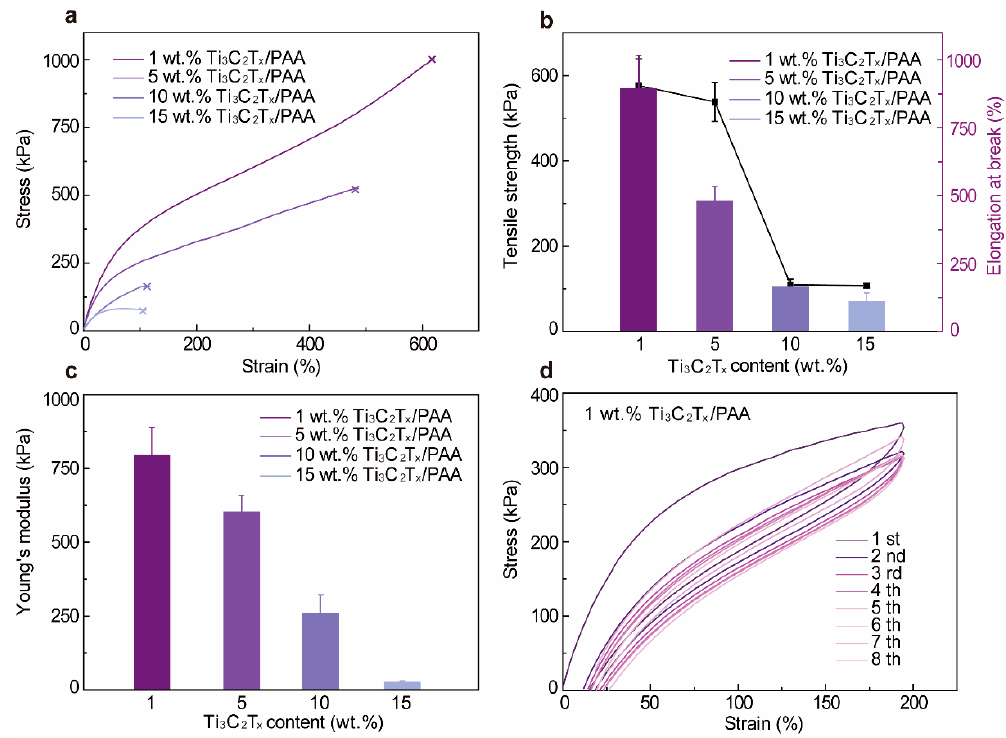
Figure 2. Mechanical properties of Ti 3 C 2 T x -PAA hydrogels. ( a ) Stress-strain curves, ( b ) tensile strength and elongation at the break, and ( c ) Young’s modulus with varying Ti 3 C 2 T x contents. ( d ) Loading/unloading stress-strain curves at the strain of 200% for 1 wt.% Ti 3 C 2 T x -PAA